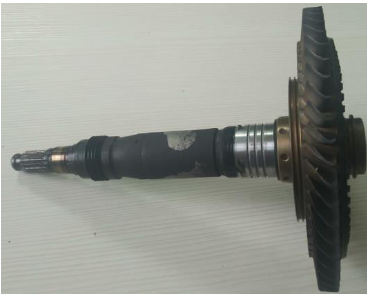
Figure 16. Compressor turbine from the GTD-350 engine.